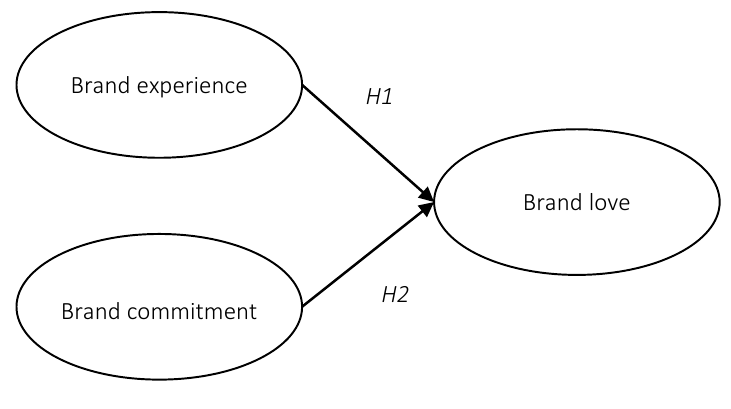
Figure 1. Research